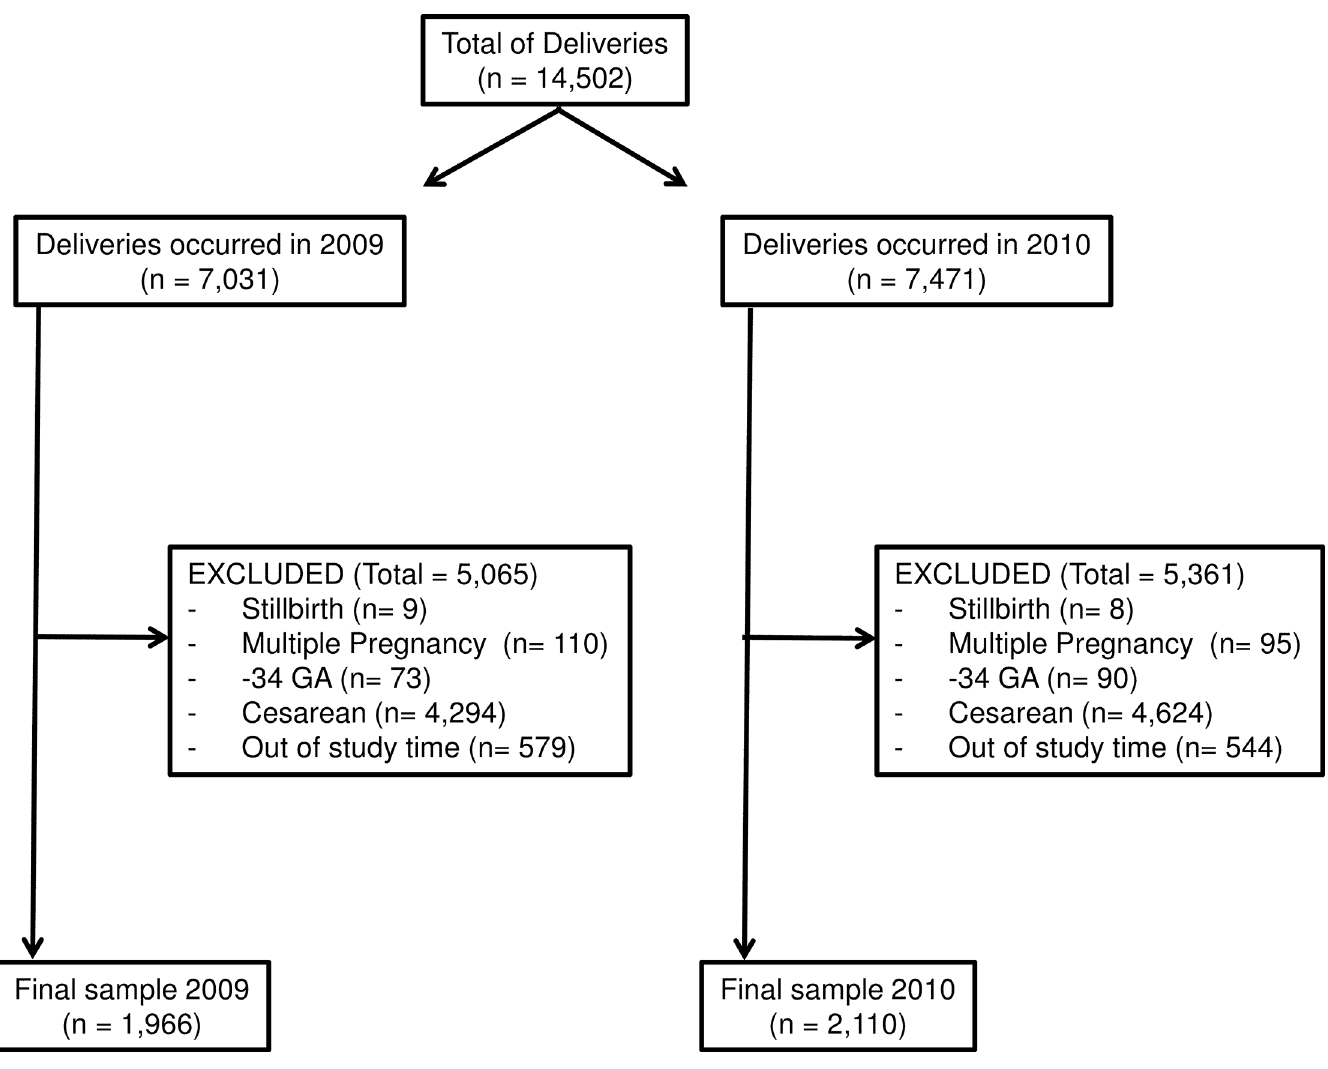
Fig 1. Flow diagram of selection of